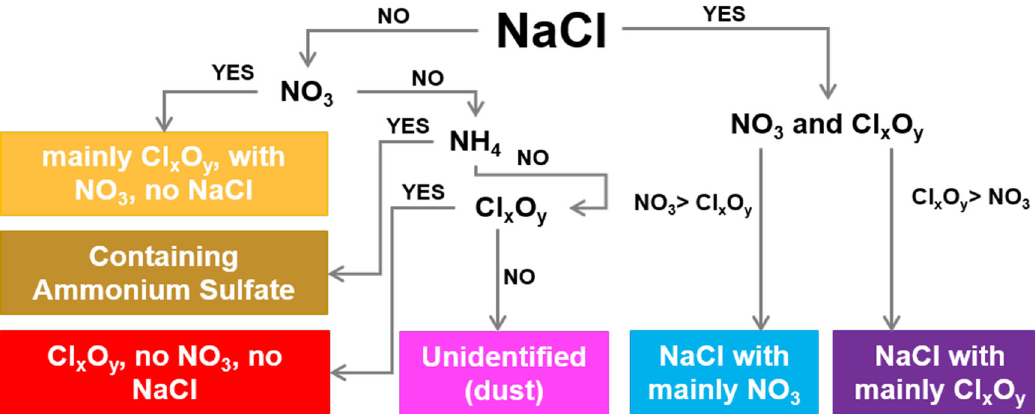
Fig. 8 Individuals ’ rule-based cluster classi fi cation. The rule-based cluster classi fi cation for individuals was applied to separate and classify 102 particles into